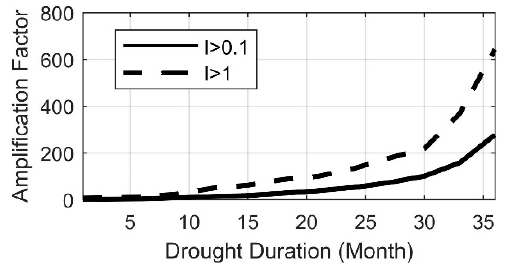
Figure 12. Amplification factor curves for frequency of drought events (intensity is in mcm/month).